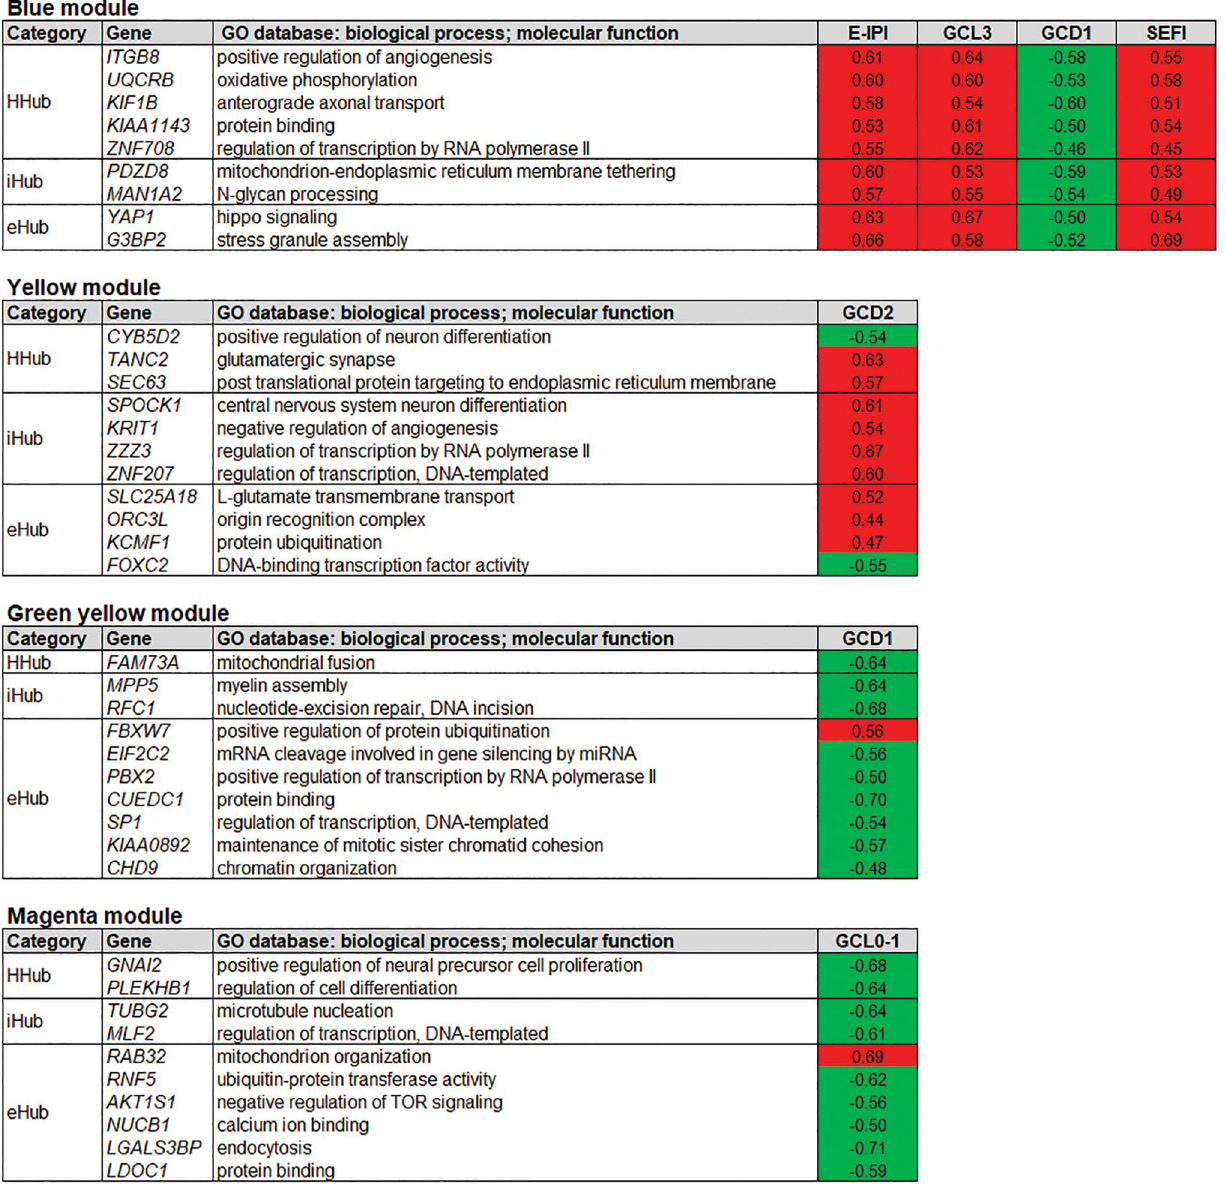
Figure 4. High hierarchical genes (Hhubs, iHubs, and eHubs) of the meta-module I present in modules highly associated with at least one trait. Each HH gene is identified by its hierarchical categorization and GO biological process or molecular function. Columns in red or in green indicate genes with positive (i.e. hyper-expressed) or negative (i.e. hypo-expressed) GS values for a specific trait, respectively. NS indicates gene with non-significant ( P ≥ 0.05) GS value for the specific trait. E-IPI stands for early IPI. SEFI stands for severe executive function impairment. The abbreviations-GCD1, GCD2, GCL0-1, GCL3, HS ILAE type 3-indicate histopathological alterations, as described in the Results and Material and Methods